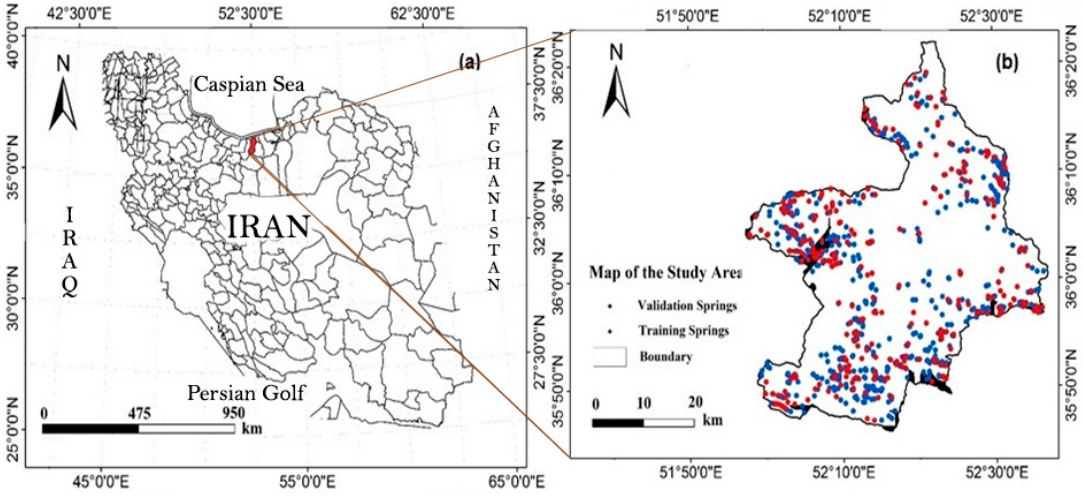
Figure 1. Specific location of the study area on the Iranian map ( a ), and the spring map for training and validation ( b ). Table 1. Lithology characteristics of the Haraz watershed, adapted from [35].